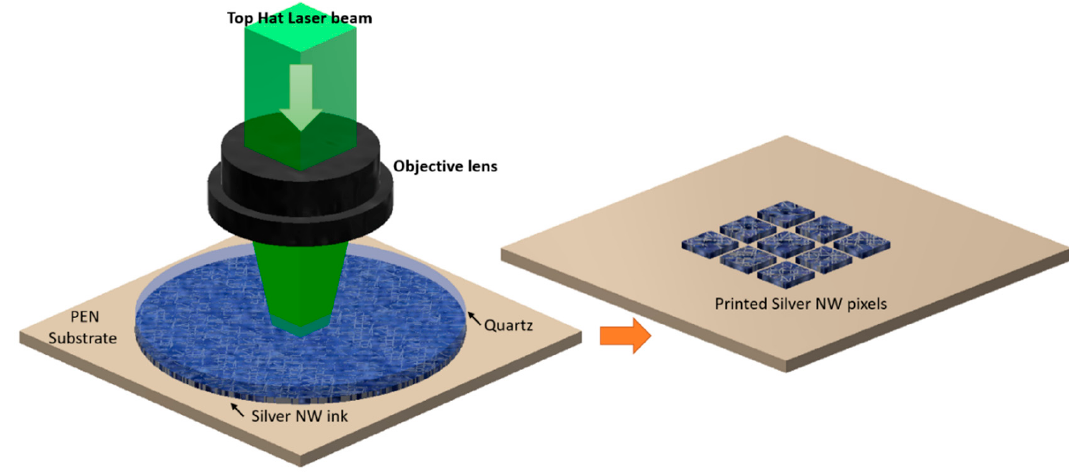
Figure 3. The Single Step Laser Transfer and Laser Curing Process. A top hat laser pulse is imaged at the interface of an Ag NW network coated on the bottom side of a quartz donor layer, donor and receiving substrates being in low vacuum contact.